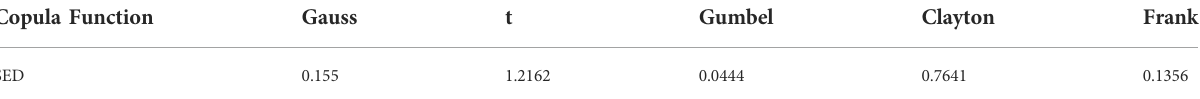
TABLE 4 Evaluation of fi tting effect of different Copula functions.